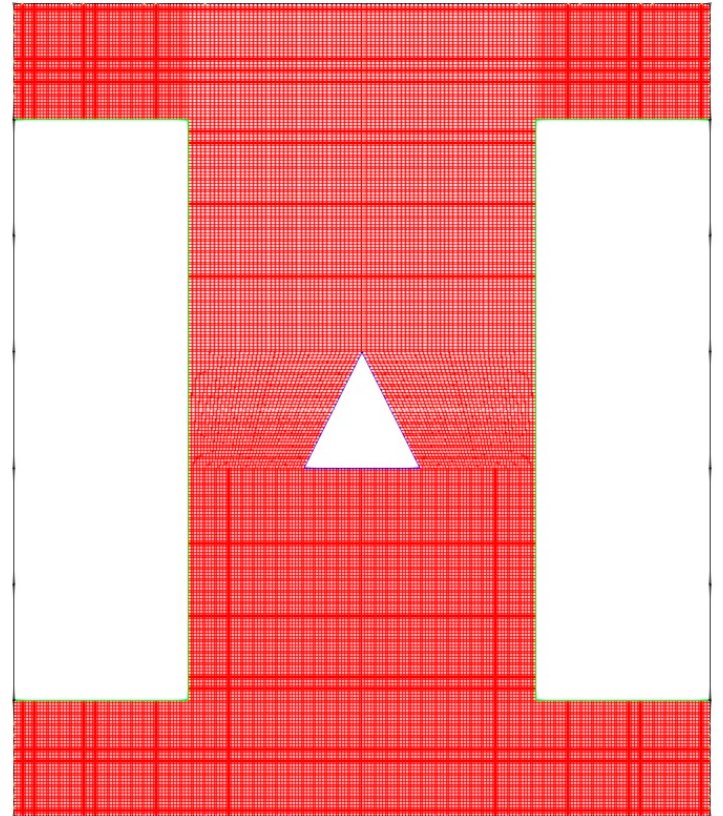
Figure 2. Mesh network for triangular hot block.